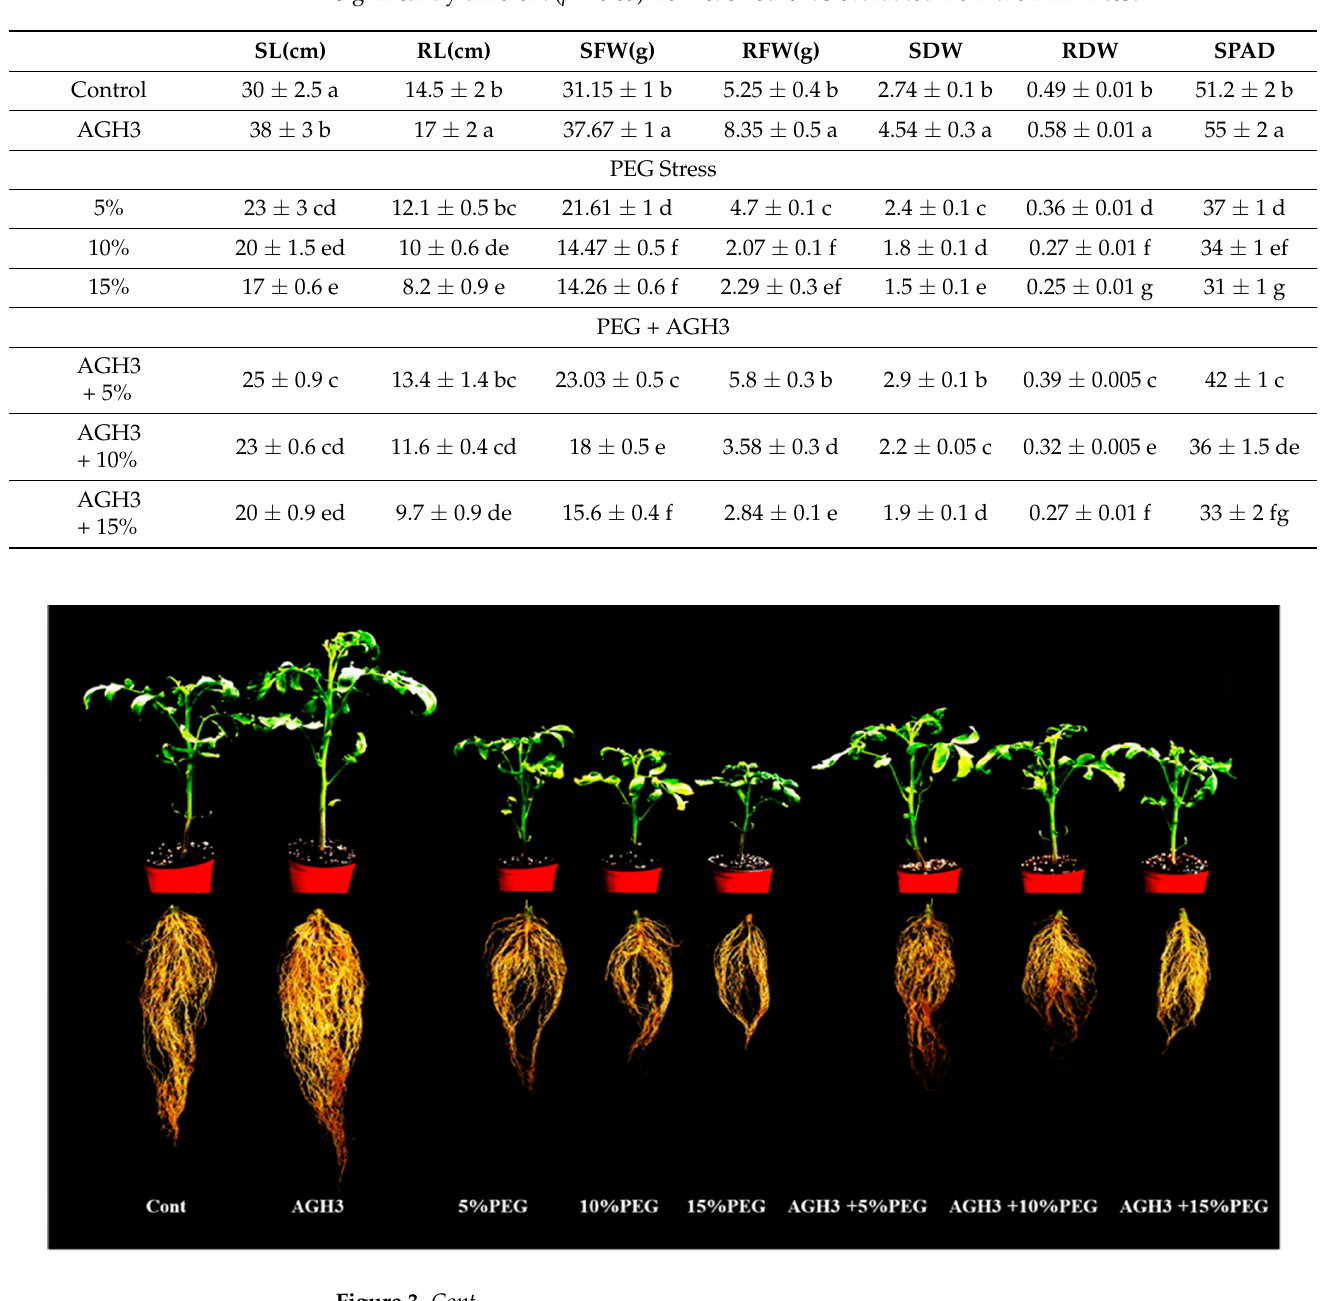
Figure 3. Effect of AGH3 on S. lycopersicum under normal and stressful conditions. 3.4. Effect of AGH3 on Plant Endogenous Abscisic Acid (ABA) and Jasmonic Acid (JA) The accumulated ABA and SA contents were assessed in S. lycopersicum plants ex- posed to normal and PEG-stressed (5%, 10%, and 15%) conditions (Figure 4). According to the results, there was no discernible variation in ABA content under normal conditions. Under different PEG concentrations, a significant increase in ABA content (2.1–4.5 fold) was observed in the non-inoculated tomato plants, while a noticeable reduction in ABA